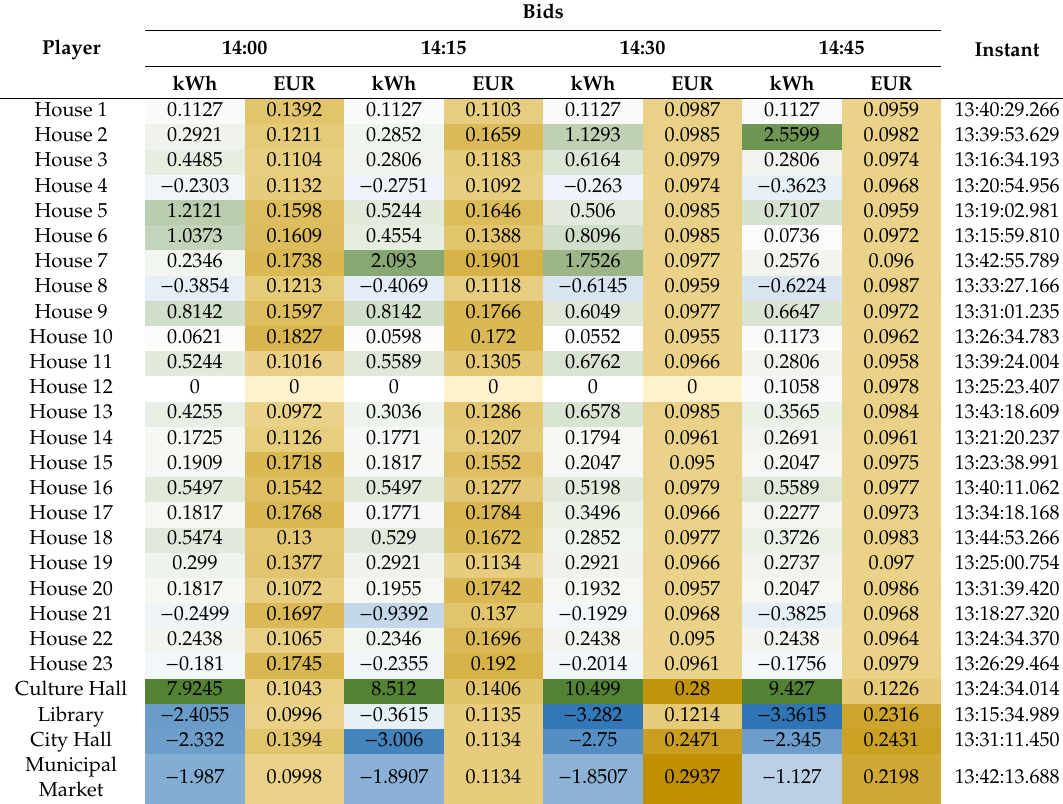
Table 2. Payers’ bids for the local market hour-ahead